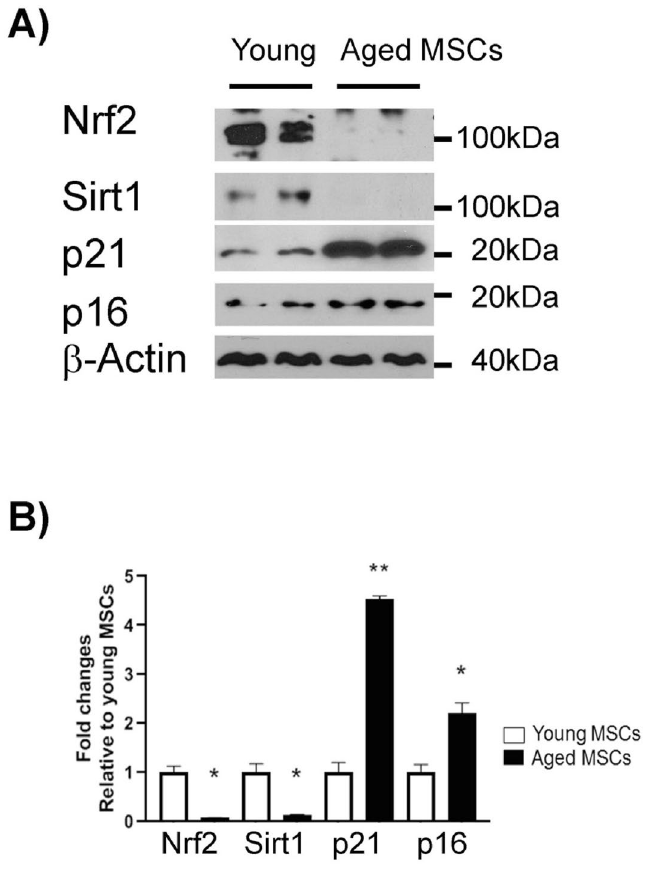
Figure 2. Characterization of young and aged MSCs by western blotting. Protein levels of four senescence markers were evaluated in young and aged MSCs at the same passage where β-actin was used as a loading control ( A ). The band intensities were quantified by ImageJ software ( B ). The bars represent means ± standard error of mean. * p < 0.05; ** p <